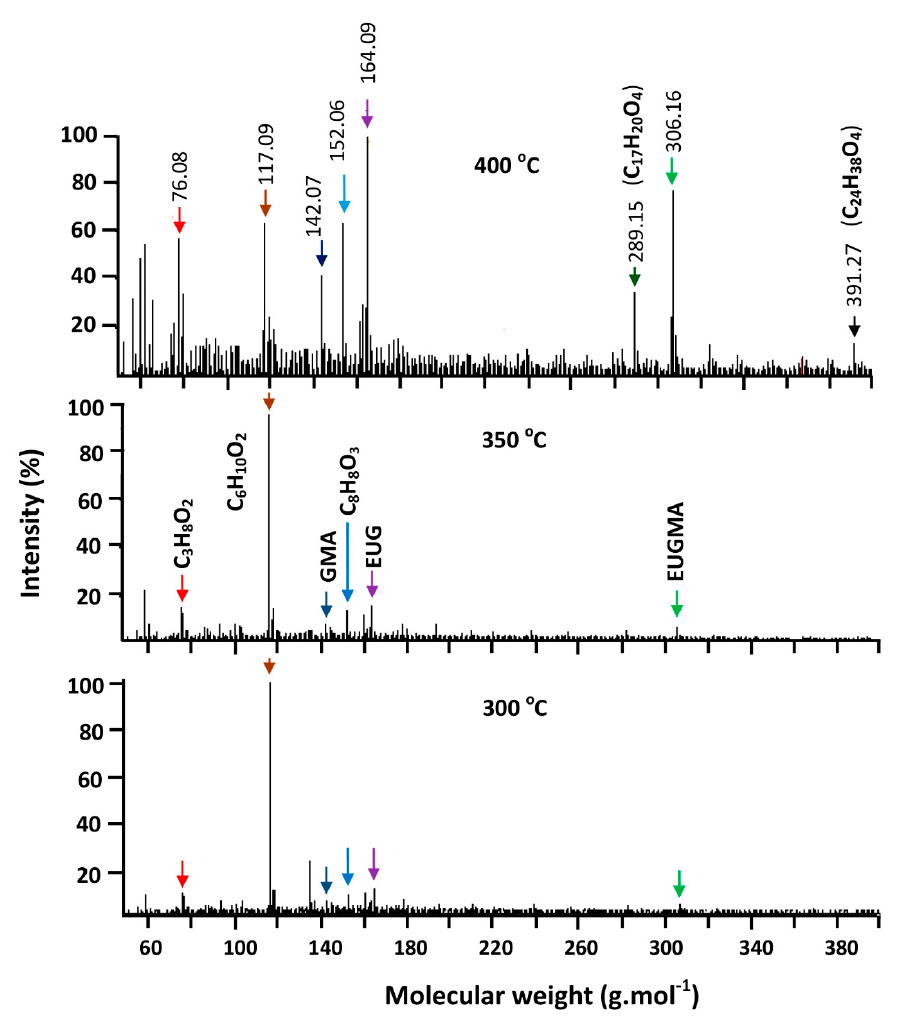
Figure 17. Thermograms of isothermal decomposition of PEUGMA indicating intensity of the absorption signal attributed to resulting products vs. molecular weight.